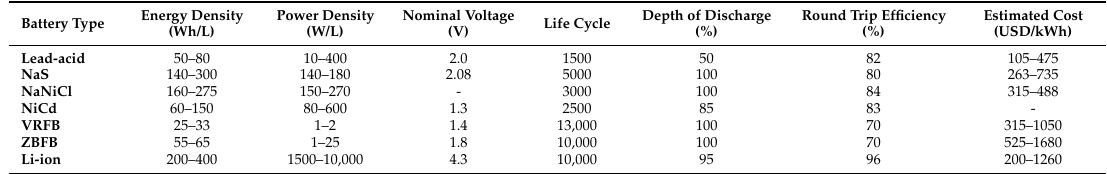
Table 1. Properties of the different types of energy storage systems [20].